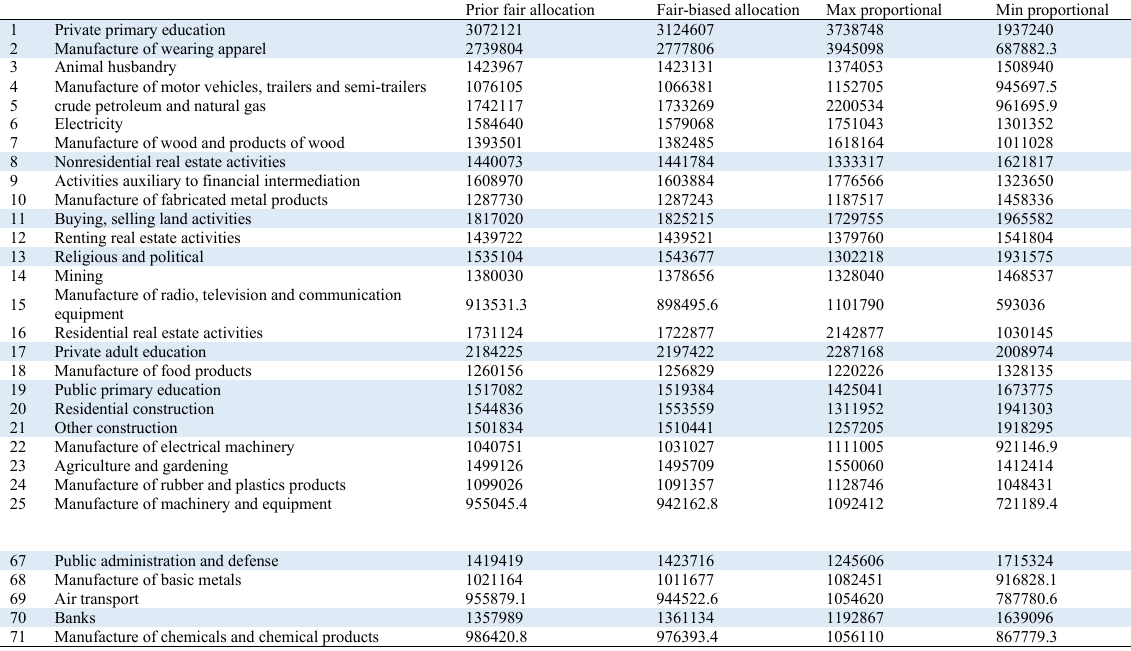
Investment allocation for economic